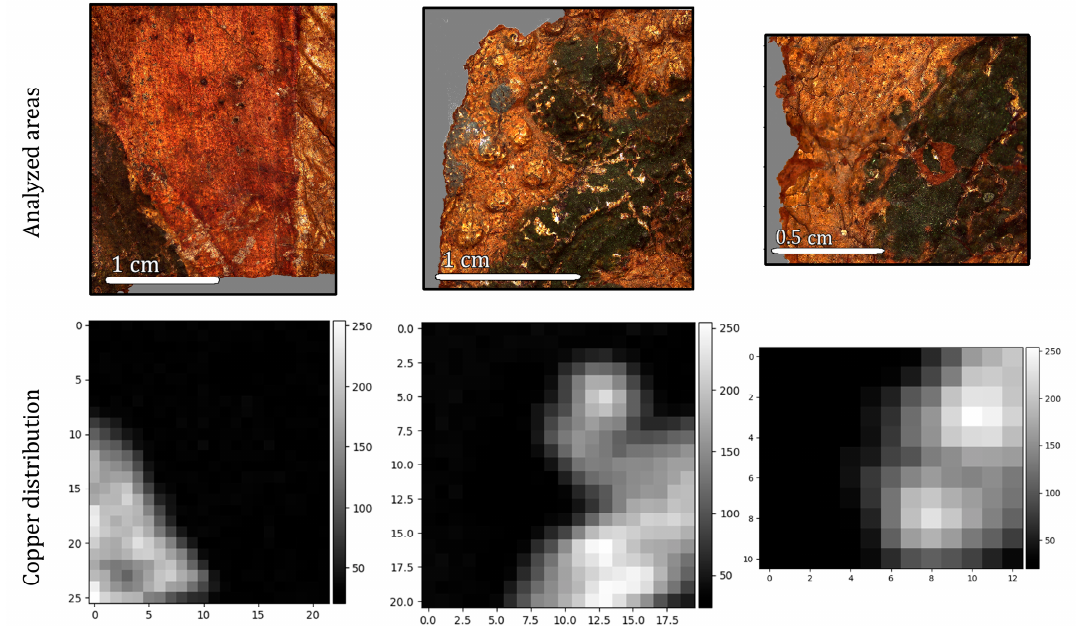
Figure 10. MA-XRF elemental maps of Cu obtained from leather samples 1 and 2 (zones 1, 2a, and 2b from left to right).